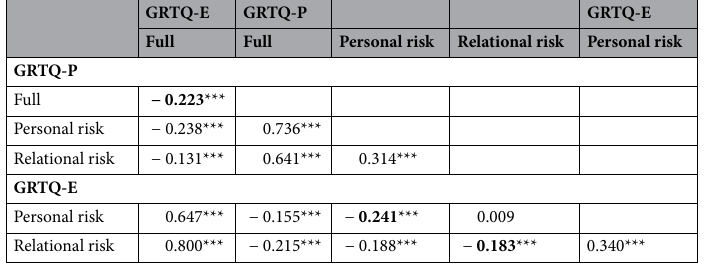
Table 2. Kendall’s tau b correlations (τ b ) between the full and subscales of the GRTQ-E and GRTQ-P derived from the factor analysis (n = 2984). *** p < 0.001. Correlations representing Risk Attitude were in